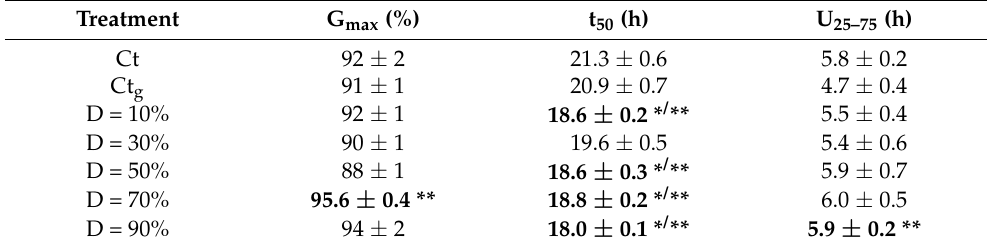
Table 1. Effect of plasma treatment on the germination of rapeseed treated with different duty cycles. Values of maximum germination (G max ), mean germination time (t 50 ), and uniformity of germination (U 25–75 ) were extracted from the fitted germination curves (Hill function). Bold numbers significantly deviated from control group (Ct) * and gas control (Ct g ) ** with p < 0.05. Treatment G max